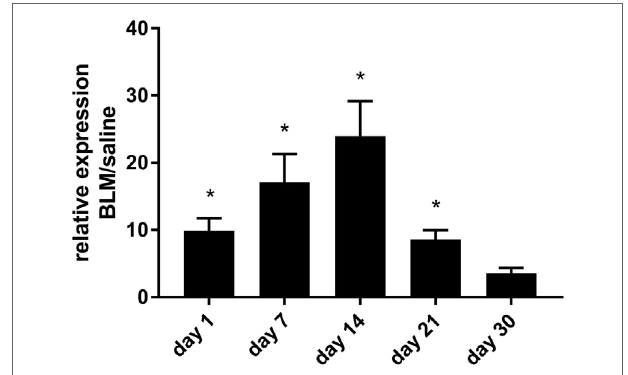
FigUre 2 | P2Y 6 R expression in bleomycin-induced pulmonary fibrosis. Male C57Bl/6 mice received an i.t. injection of BLM or vehicle on day 0. Animals were killed at the indicated time points and P2Y 6 R expression in lung tissue was analyzed by quantitative RT-PCR ( n = 3–4 per group) (* p < 0.05).